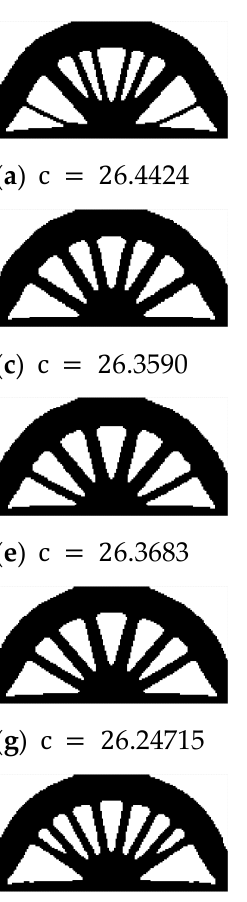
Figure 9. Simplified model of half-wheel beam.